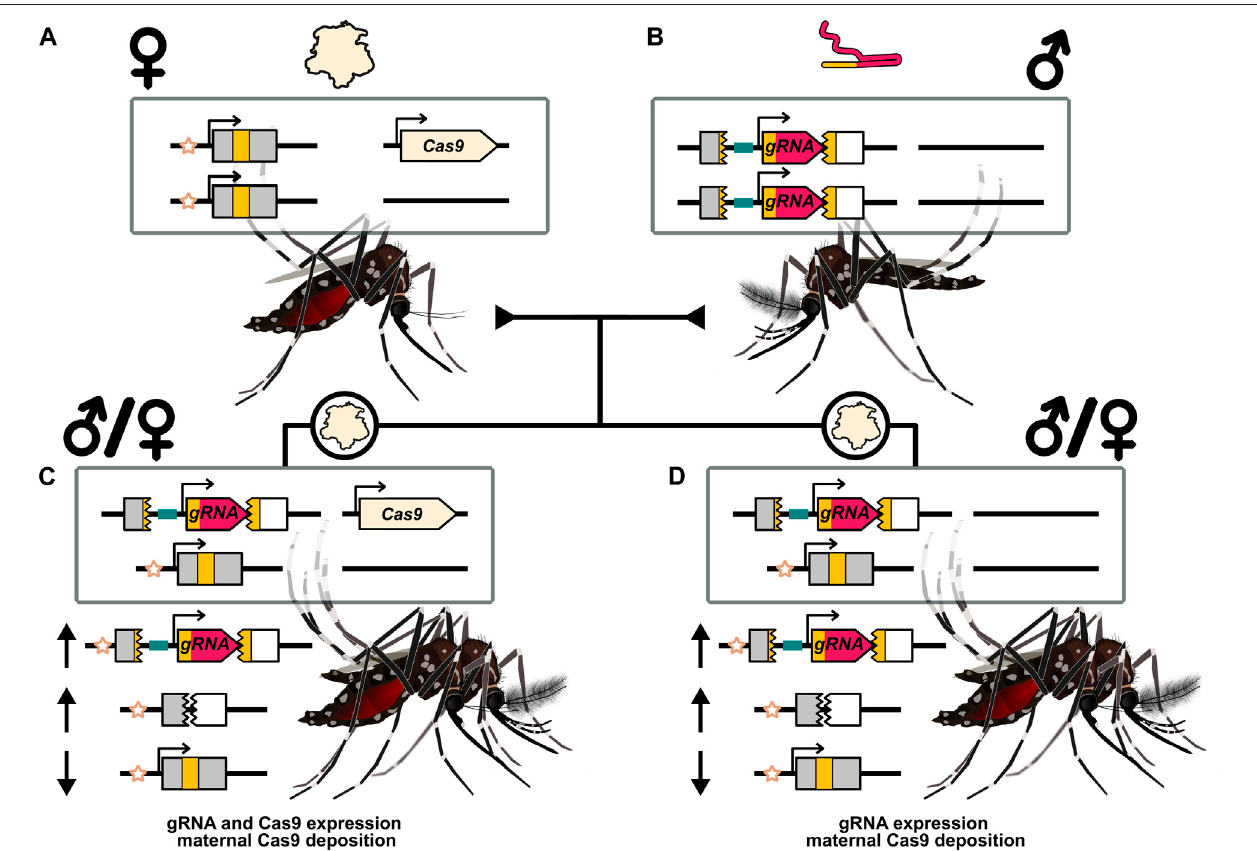
FIGURE4| Illustration ofmaternaldepositionandshadow driveinthecontextofasplit-drive. (A) AfemalecarryingaCas9split-driveelementand depositingCas9 protein into her eggs. (B) A male that carries the gRNA drive element and does not deposit the expressed gRNA. (C) Progeny of either sex that inherited the two transgenes from each parent separately. Expression of the Cas9 and gRNA genes can allow for inheritance bias. (D) Progeny of either sex that inherited the gRNA gene fromtheirfatherbutnottheCas9genecarriedbytheirmother.MaternaldepositioncannonethelessprovideasourceofCas9thatcancomplexwiththeexpressed gRNA and mediate inheritance bias of the gRNA drive element. This is termed shadow drive. The recipient chromosome marker (star symbol) is used to indicate the target alleles that have been replaced by the drive element. Inheritance biasing mechanism of drive expression and/or deposition could operate through a non-copying mechanism. The arrows indicate a relative increase (upward arrow) or decrease (downward arrow) of the particular allele. While mosquitoes are illustrated Ramírez (2019a,b), these results have primarily been documented in Drosophila .